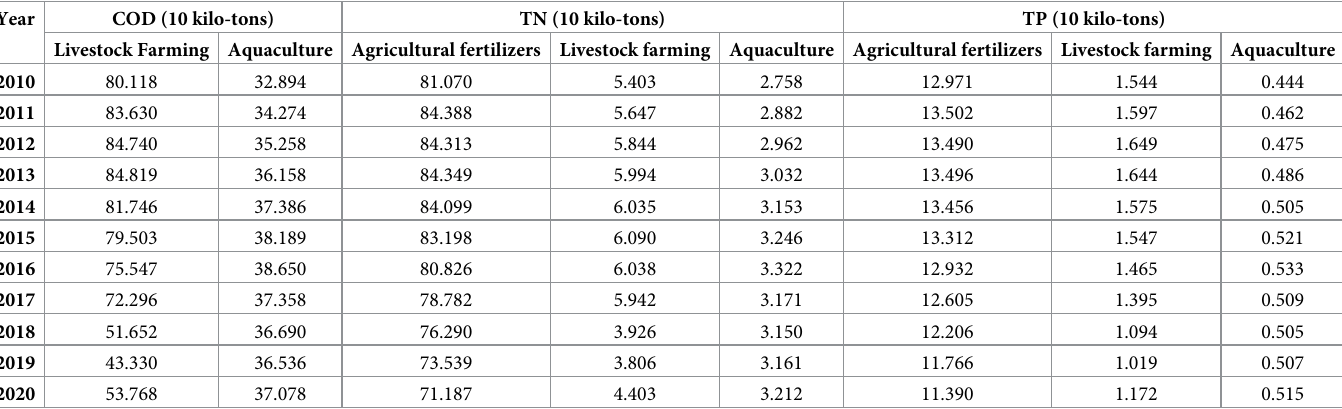
Table 4. Amount of agricultural nonpoint source pollution in the YRD, from 2010 to 2020.